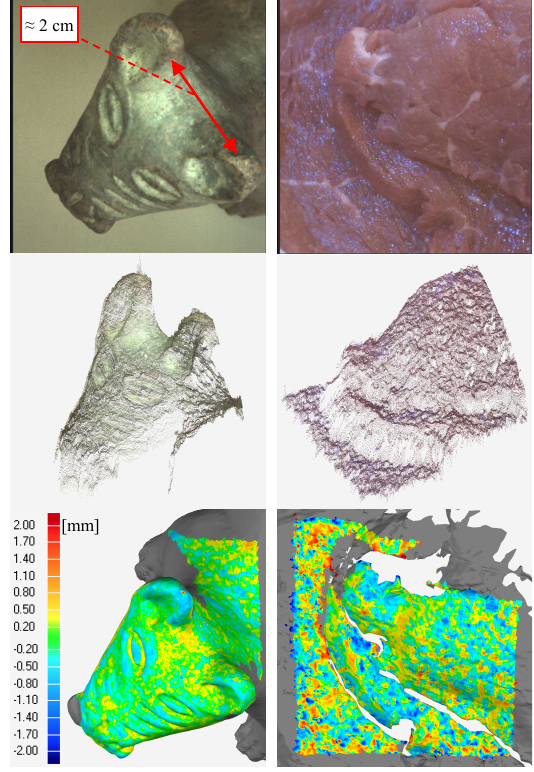
Figure 5. Test objects (top), resulting point clouds (centre) comparisons with reference model (bottom) Statue Meat points points Ref. Point cloud